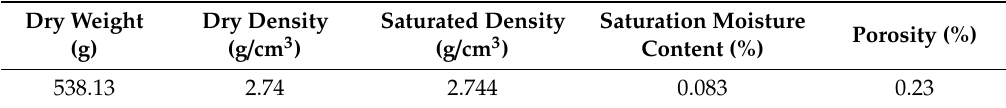
Table 1. Original properties of tonalite.